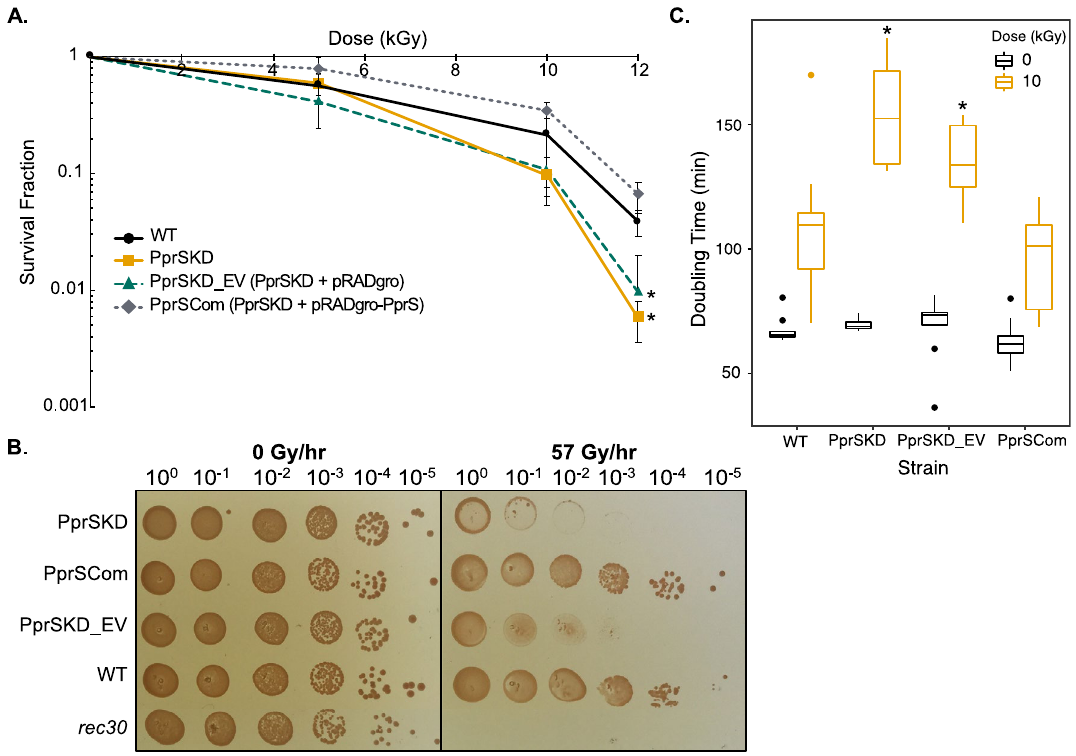
Figure 2. PprSKD showed reduced survival to acute IR and reduced growth under both acute and chronic IR. ( A ) Survival curve of D. radiodurans PprS knockdown mutant (PprSKD), PprSKD with empty plasmid control (PprSKD_EV), PprS complementation (PprSCom) and WT at different doses of acute IR. Error bars represent standard deviation of biological triplicates and * p -value < 0.05 between the strain compared to WT by two-tailed Student’s t-test. (B) Growth of WT, PprS knockdown and complement strains, and a recA defect strain (rec30) under chronic irradiation at 57 Gy/h for 5 days. Numbers over the images indicate the dilution ratio of colonies. ( C ) Doubling time of biological triplicates of WT and PprS knockdown and complement strains during recovery from 10 kGy acute IR or sham exposures. Knockdown of PprS does not impact D. radiodurans growth phenotype during unirradiated conditions. However, PprSKD demonstrates a significant reduction in growth rate during recovery from IR compared to WT. This growth defect after IR is lost after PprS complementation. * p -value < 0.05 for each comparison by two-tailed Student’s